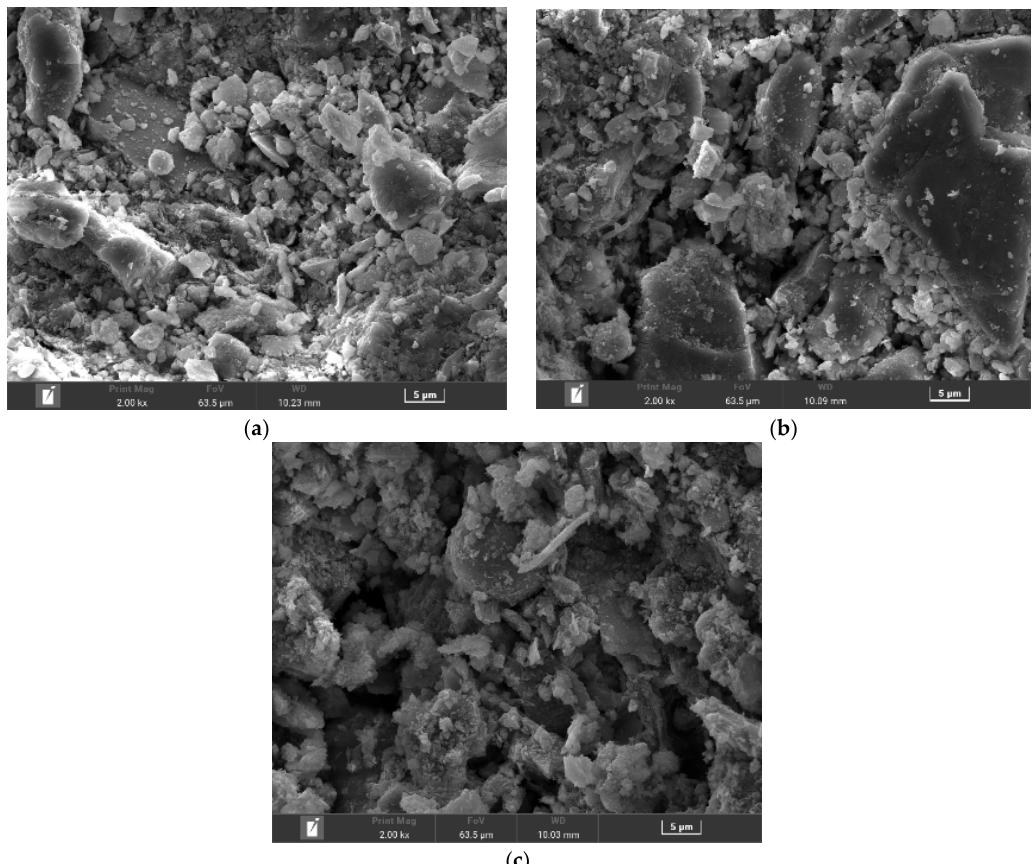
Figure 9. SEM Images of MS7 modified dredged sludge sample. ( a ) 0~2 cm sample, ( b ) 4~6 cm sample, ( c ) 8~10 cm sample.